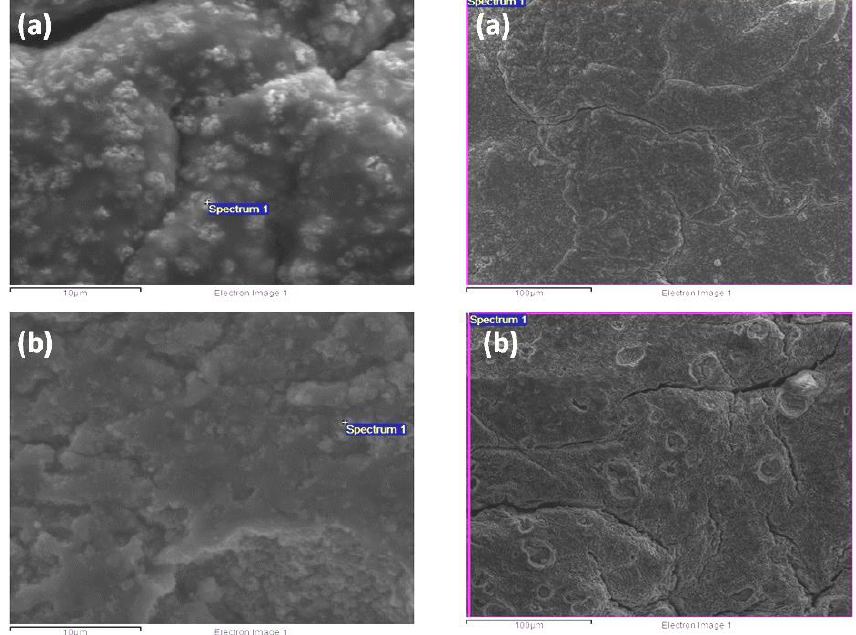
Figure 5. Morphology of catalyst: ( a ) TiO 2 /Fe 3 O 4 -CS(2) before use, ( b ) TiO 2 /Fe 3 O 4 -CS(2) after use.